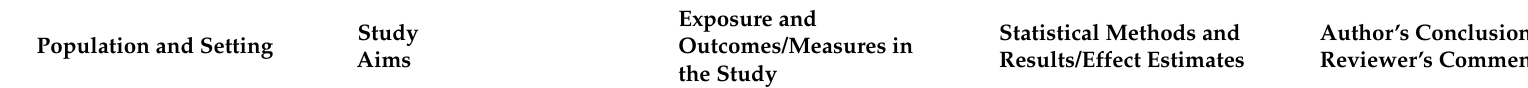
Table A2. Characteristics and summary of quantitative studies